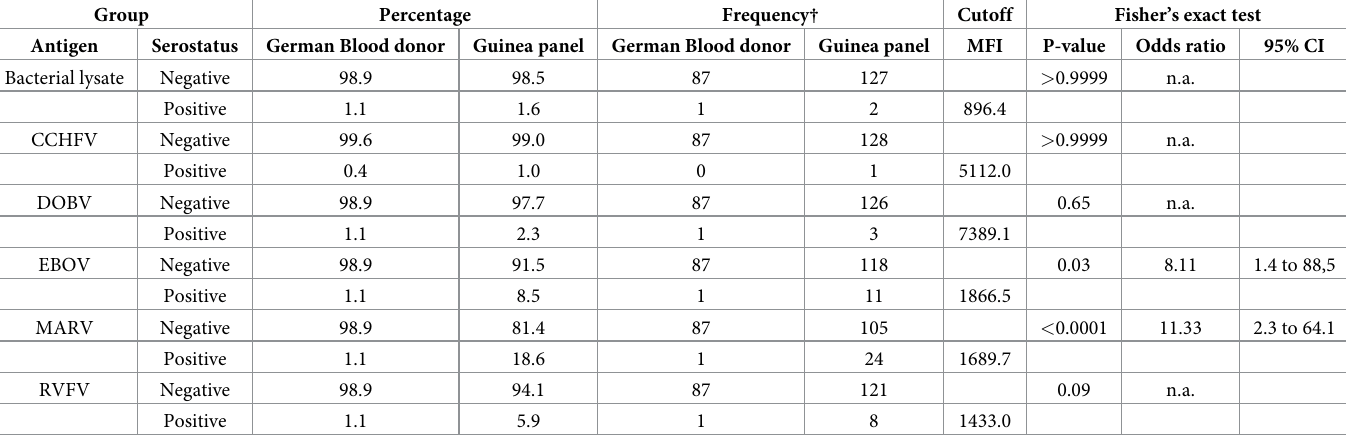
Table 2. Comparison of the number of serum samples that tested positive and negative against each viral NP in the German blood bank and Guinean serum sample sets. The median MFI readings from three technical replicates per sample were analysed in R, and a positive or negative status was assigned to each serum sample. Positiv- ity or negativity was based on a cutoff MFI value that was determined for each viral NP based on the 99 th percentile for MFI values in the German blood bank sample set. Statistically significant differences in seroprevalence rates between the two sample sets and odds ratios were calculated using Fisher’s exact